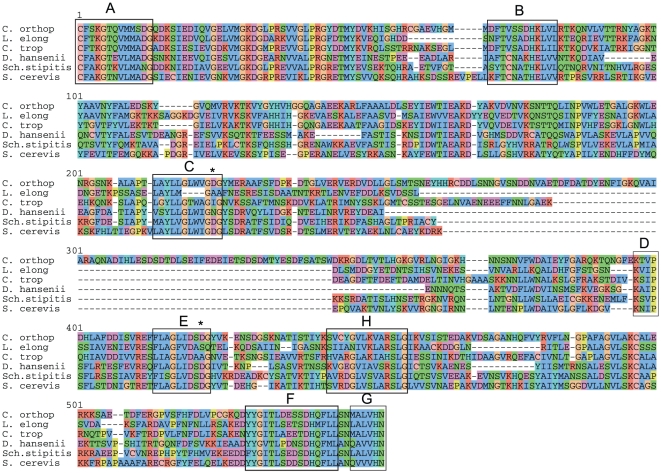
Identification of intein sequences in the Vma1 proteins of Candida species.The figure shows the alignment of the intein (VDE) sequences only; the alignment of the entire Vma1 proteins is shown in Figure S5. The motifs are labeled according to the nomenclature of Perler et al [102]. Motifs A, B, F and G are important for self-splicing. Motifs C, D, E and H are associated with homing. Two aspartic acids within the LAGLIDADG motifs in C and E that are required for homing are indicated with asterisks. The protein sequences were aligned and visualized using SeaView [122].